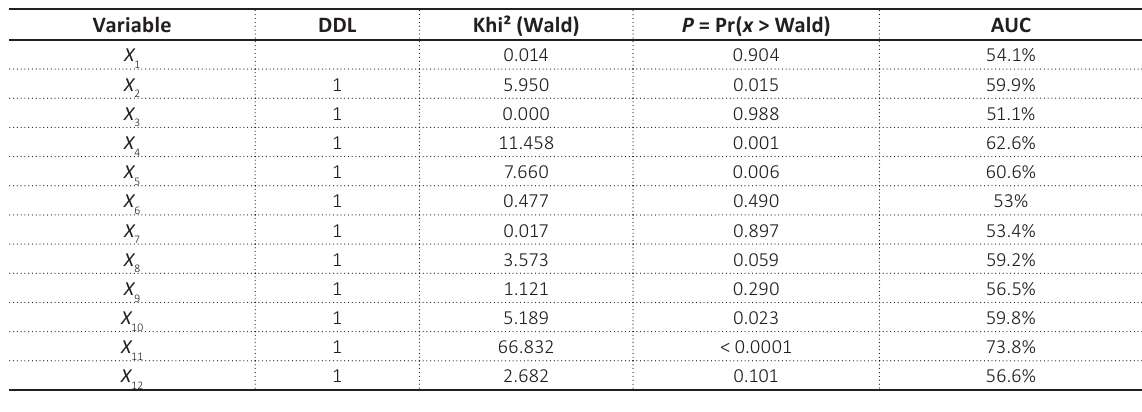
Table B2. Discriminative power of models as a function of variables Model